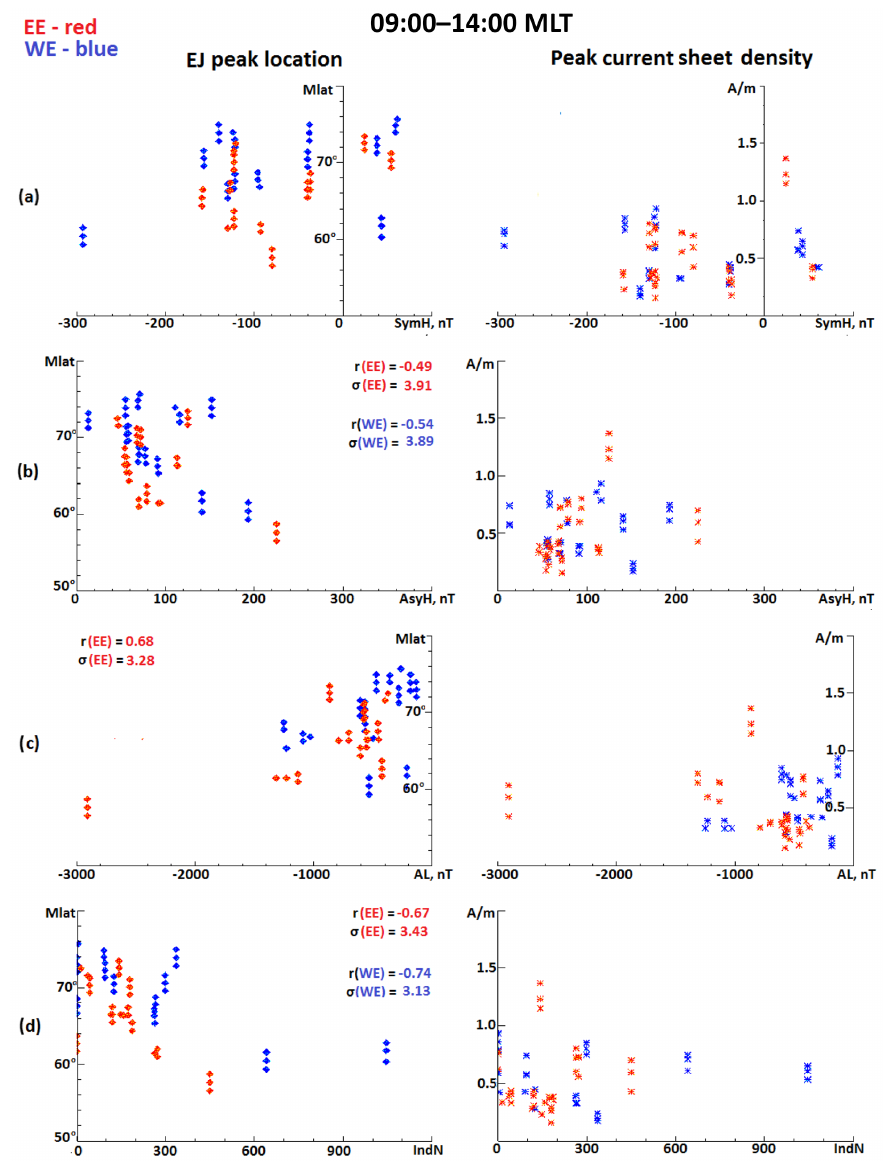
Figure 4. For the daytime sector (09:00–14:00MLT), the dependence of the magnetic latitude MLat’s (degrees) position at the peak (left column) and the intensity ( I in Am − 1 , right column) of the Hall current in the WE (blue) and EE (red) in the geomagnetic activity indices SymH (a) , AsyH (b) , AL (c) , and the solar wind coupling function IndN (d) . For the cases of correlations with r > 0 . 46, the correlation coefficients ( r ) and the dispersion ( σ ) according to a linear regression are shown as